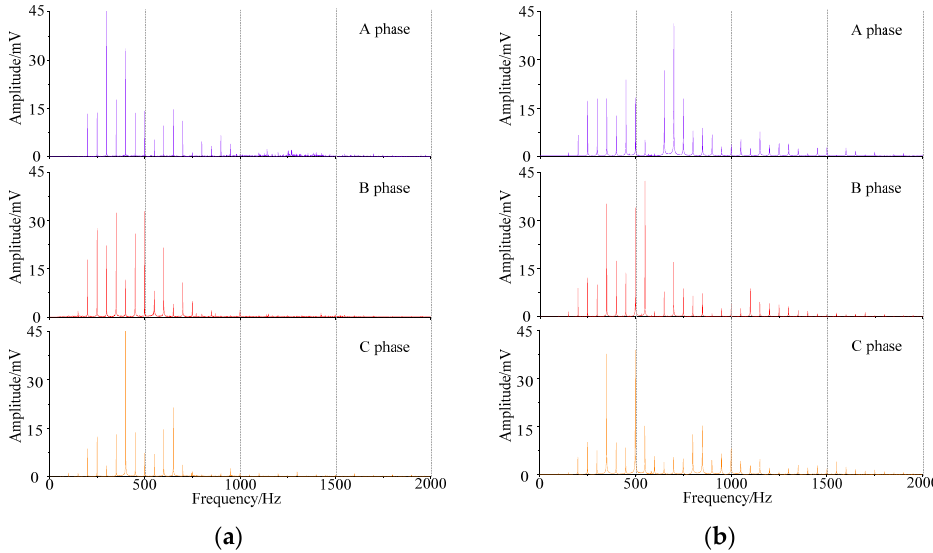
Figure 4. The 500 kV transformer acoustic signal frequency spectrum. ( a ) Normal state. ( b ) DC bias state.